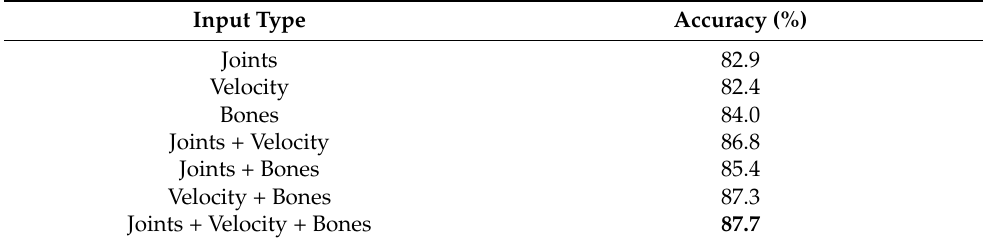
Table 2. Performance for multiple data inputs for joints, velocity, and bones.